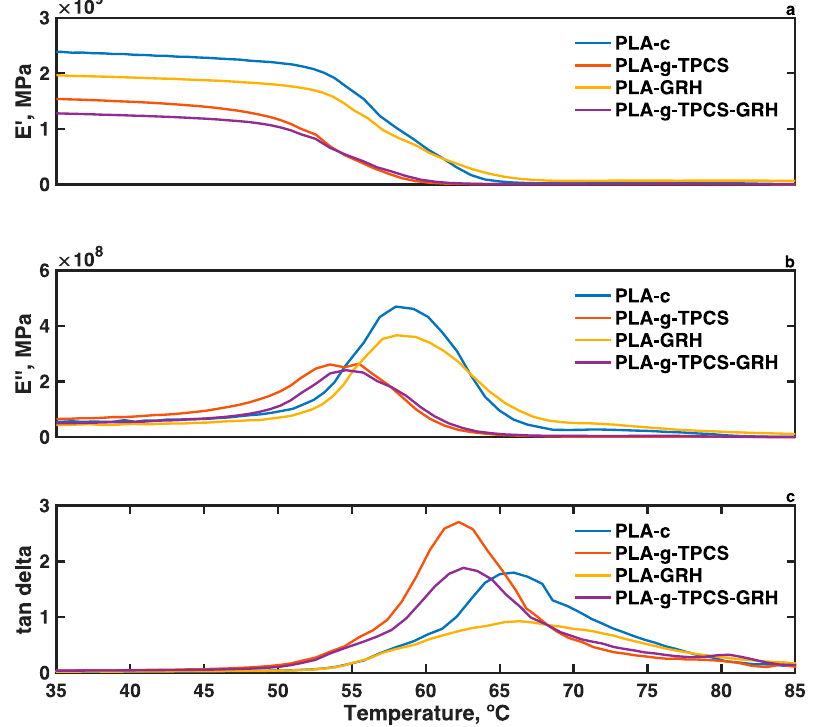
Figure 6. Dynamic mechanical analysis (DMA) thermograms of films produced by twin-screw extrusion–cast-film extrusion: ( a ) E ʹ , storage modulus; ( b ) E ʺ , loss modulus; and ( c ) tan delta. extrusion–cast-film extrusion: ( a ) E (cid:48) , storage modulus; ( b ) E (cid:48)(cid:48) , loss modulus; and ( c ) tan